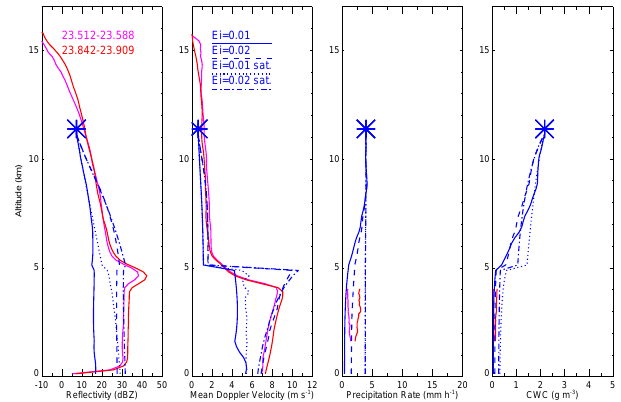
Figure 12. Same as Fig. 11 except that the initial ice size distribu- tion is scaled by a factor of